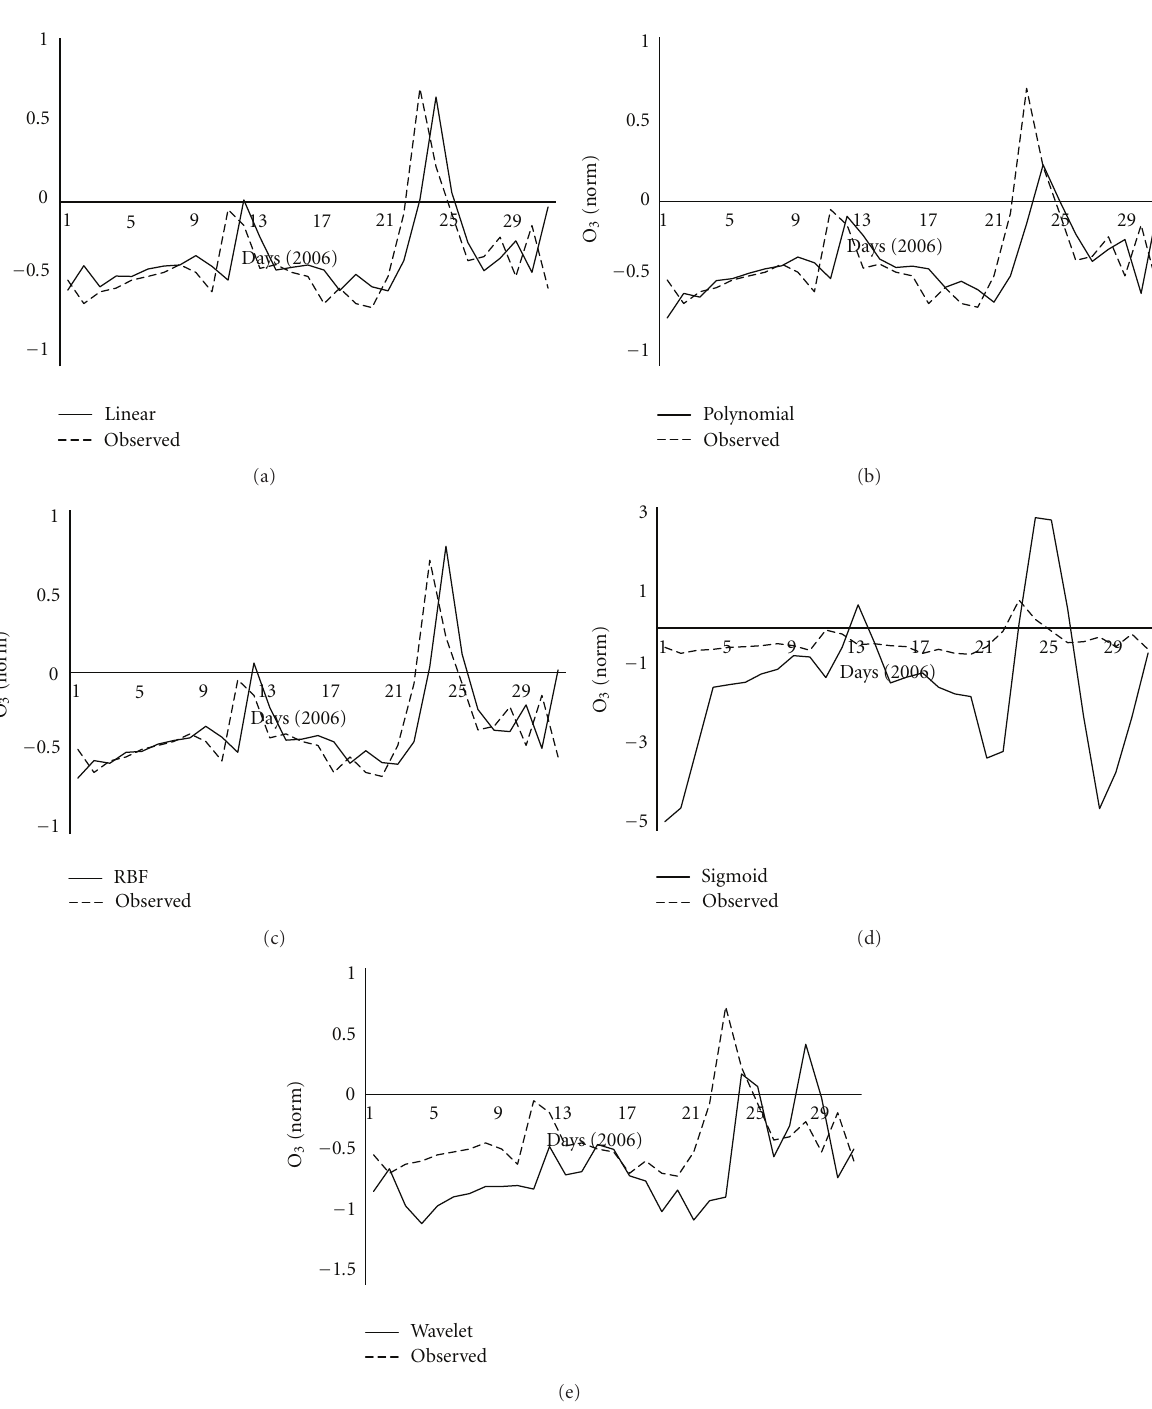
Figure 6: The predicted and observed levels of O 3 using di ff erent kernel models in summer experiment